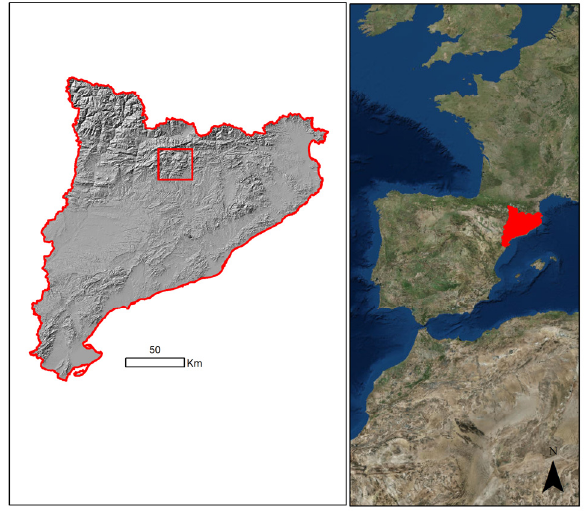
Figure 1. Location of the study area in Catalonia and Spain.